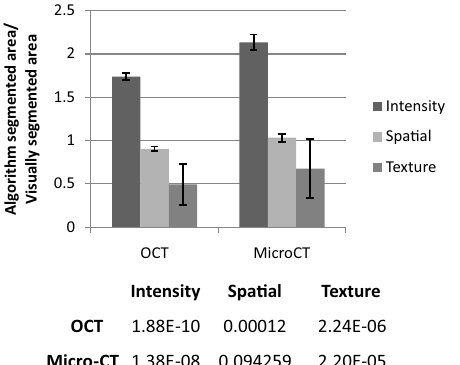
Fig. 5. Average area of tumor found by each segmentation method, normalized to visual segmentation (training dataset, n ¼ 25) with error bars representing standard deviation. A Student's t -test comparing the mean of areas found by each method with the mean obtained by visual inspection was performed. The p -values are shown in the table. Note, because the data is normalized, areas closer to 1 more closely approach the area determined by visual segmentation.